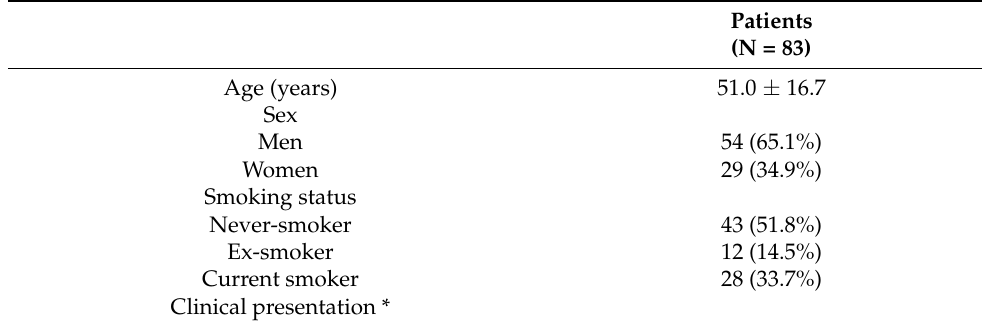
Figure 2. Patient enrollment flow chart. Table 1. Baseline patient characteristics.